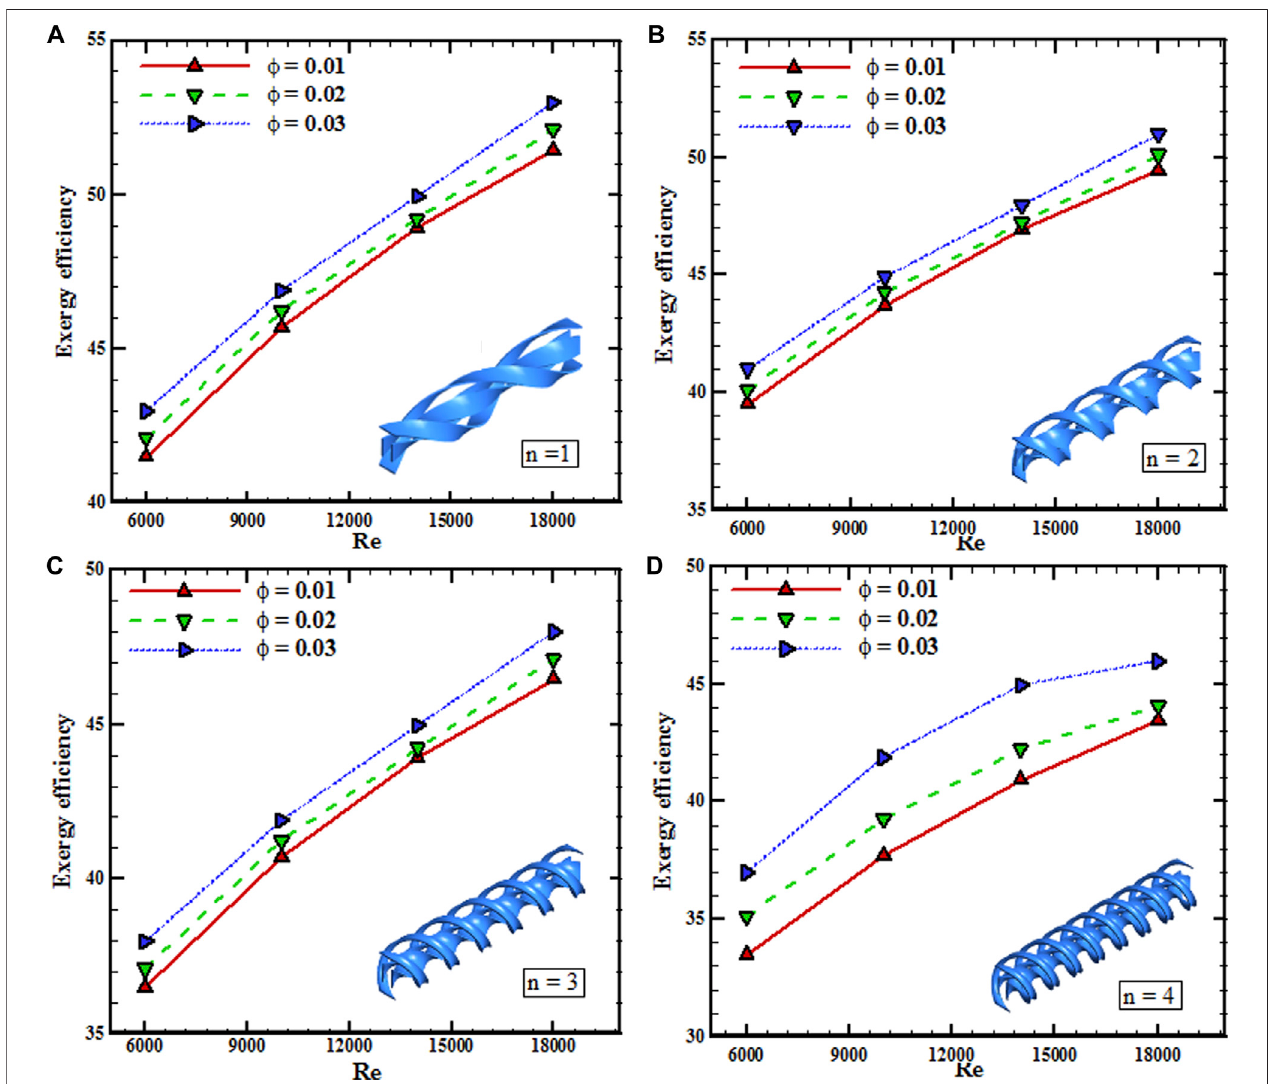
FIGURE 11 | The variations of exergy ef fi ciency (A) n (cid:1) 1, (B) n (cid:1) 2, (C) n (cid:1) 3, and (D) n (cid:1) 4.